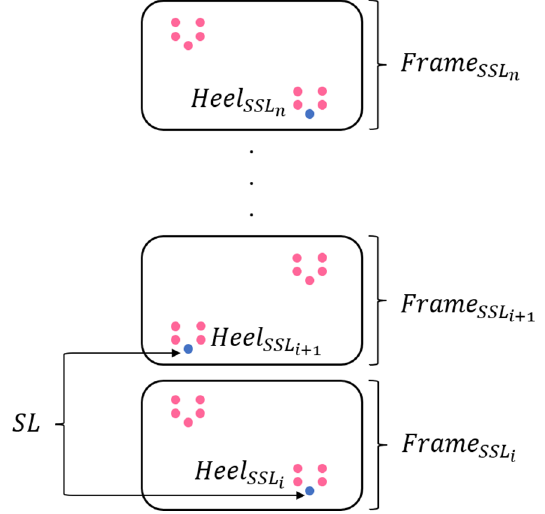
Figure 10. Determination of step length from the cloud points data.